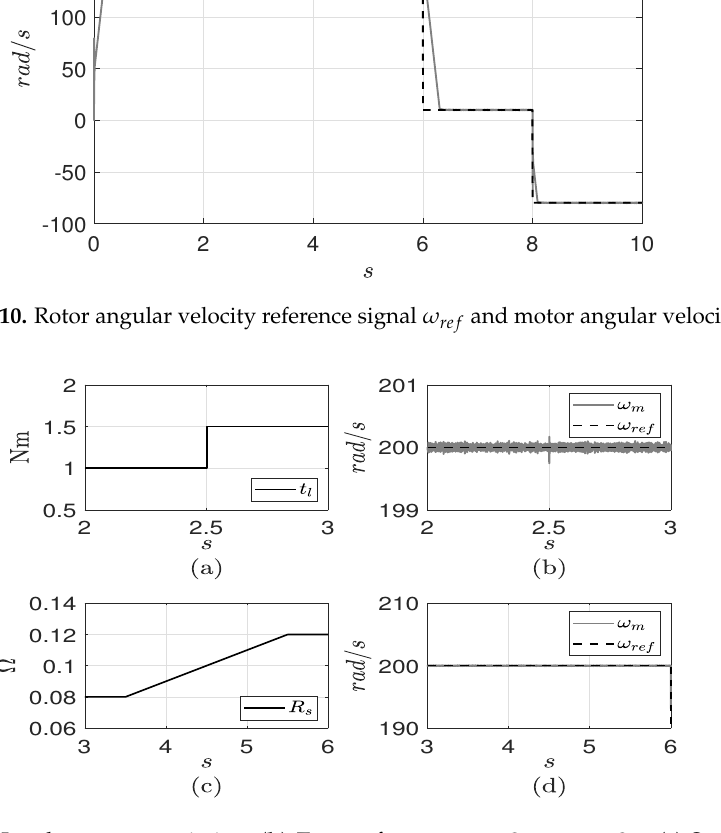
Figure 11. ( a ) Load torque t l variation; ( b ) Zoom of ω ref , ω m at 2 s ≤ t < 3 s; ( c ) Stator resistance R s variation; ( d ) Zoom of ω ref , ω m at 3 s ≤ t < 6 s.